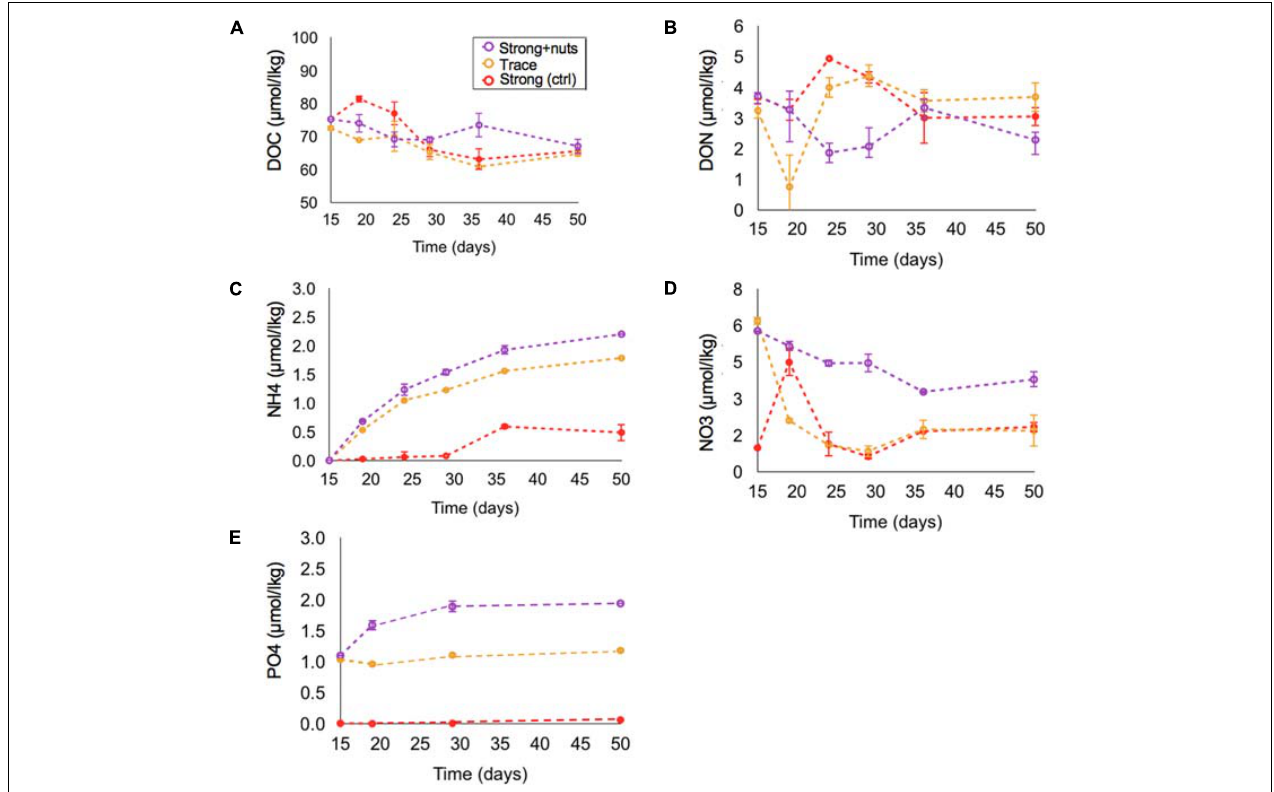
FIGURE 4 | Variation in concentrations versus time in the strong upwelling treatments following inorganic nutrient additions and/or trace metals: DOC (A) , DON (B) , NH